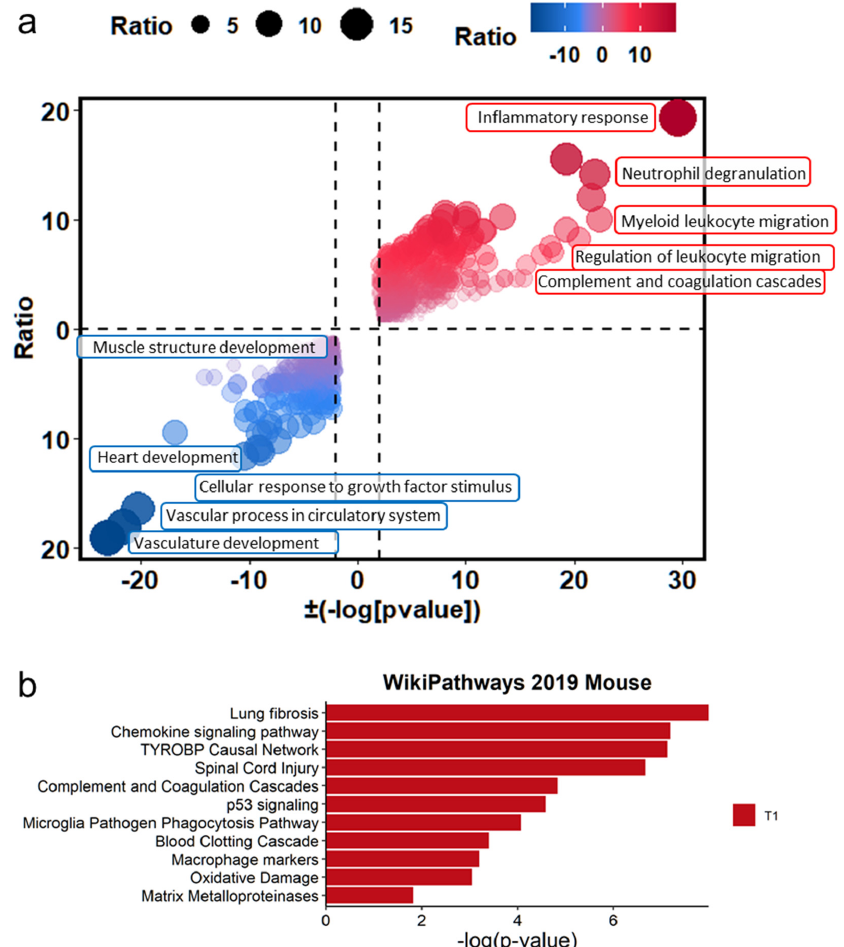
Figure 3. The difference in biological signatures between the control and PHMG ‐ P ‐ treated groups. a. Gene set enrichment test based on gene ontology categories. b. Biological pathways significantly changed by PHMG ‐ P treatment. The signifi ‐ cant p ‐ values were converted to − log( p ‐